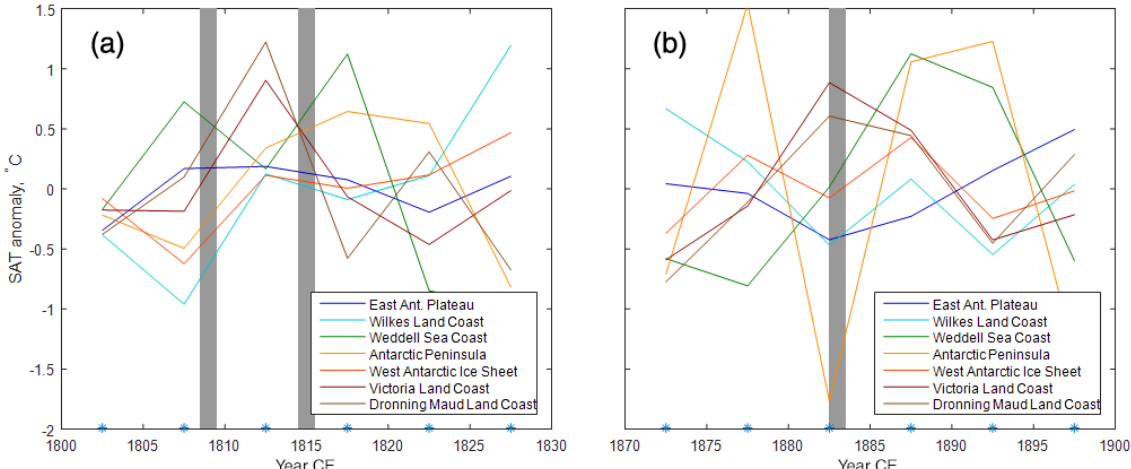
Figure 9. Reconstructed regional surface atmospheric temperature anomalies during the periods of 1802.5–1827.5CE (a) and 1872.5– 1897.5CE (b) overlapping with the three major tropical volcanic eruptions of 1808/09, Mount Tambora 1815 and Krakatoa (1883). The reconstruction segments for each region were centred on the means of the corresponding intervals. Stars mark the bin centres of the recon- structions, and the years of the eruptions are highlighted in